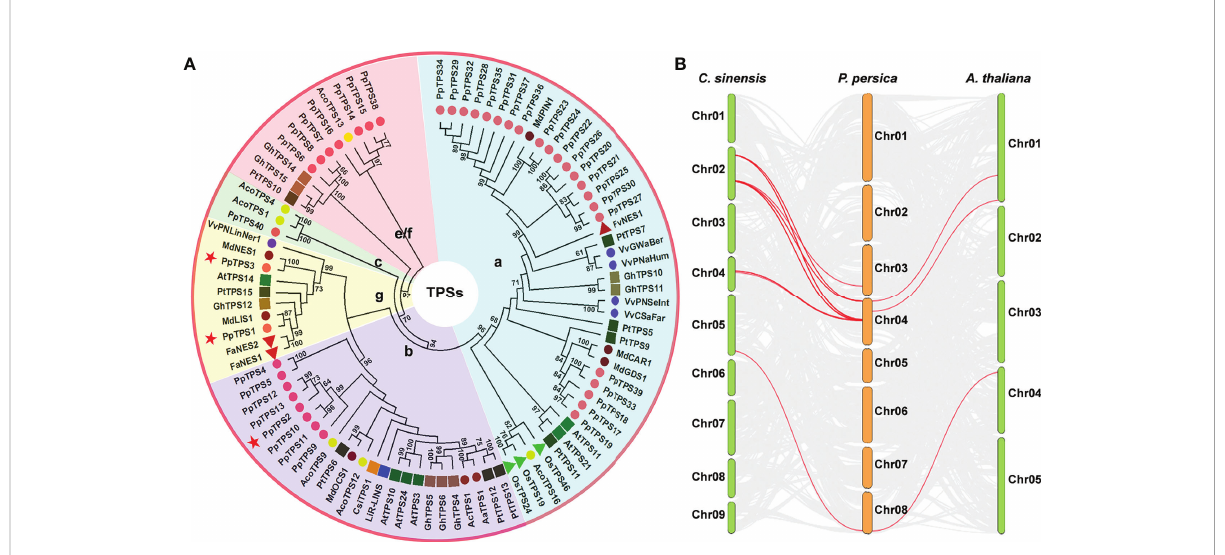
FIGURE 1 Evolutionary analysis of PpTPS genes. (A) A phylogenetic tree that was constructed using the full-length amino acid sequences of 40 TPSs from Prunus persica and 50 function-de fi ned TPSs from Arabidopsis thaliana , kiwifruit ( Actinidia arguta , Actinidia chinensis ), pineapple ( Ananas comosus ), sweet orange ( Citrus sinensis ), strawberry ( Fragaria ananassa , Fragaria vesca ), cotton ( Gossypium hirsutum ), apple ( Malus domestica ), rice ( Oryza sativa ), poplar ( Populus trichocarpa ), and grapevine ( Vitis vinifera ). The phylogenetic tree was constructed with MEGA 11 using the Neighbor-joining method and the amino acid sequences were obtained from the previous studies (Aharoni et al., 2004; Tholl et al., 2005; Martin et al., 2010; Nieuwenhuizen et al., 2013; Nieuwenhuizen et al., 2015; Yoshitomi et al., 2016; Alquezar et al., 2017; Chen et al., 2017; Sun et al., 2017; Chen et al., 2018; Huang et al., 2018). The detailed accession numbers of all the TPS proteins were presented in Supplementary Table 3. Red stars denote three function-de fi ned PpTPS proteins in previous studies. (B) The synteny analysis of TPS genes from Prunus persica , Arabidopsis thaliana , and Citrus sinensis